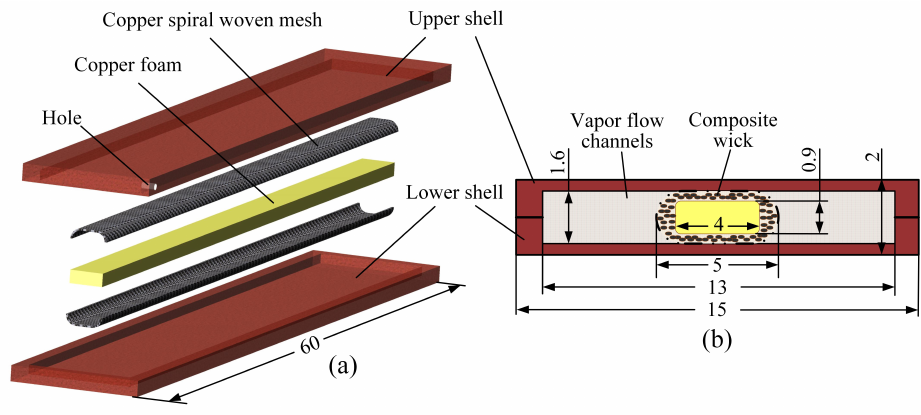
Figure 1. Schematic diagram of CW-FMHP measured in mm. ( a ) Exploded Views of CW-FMHP; ( b ) Cross section diagram of